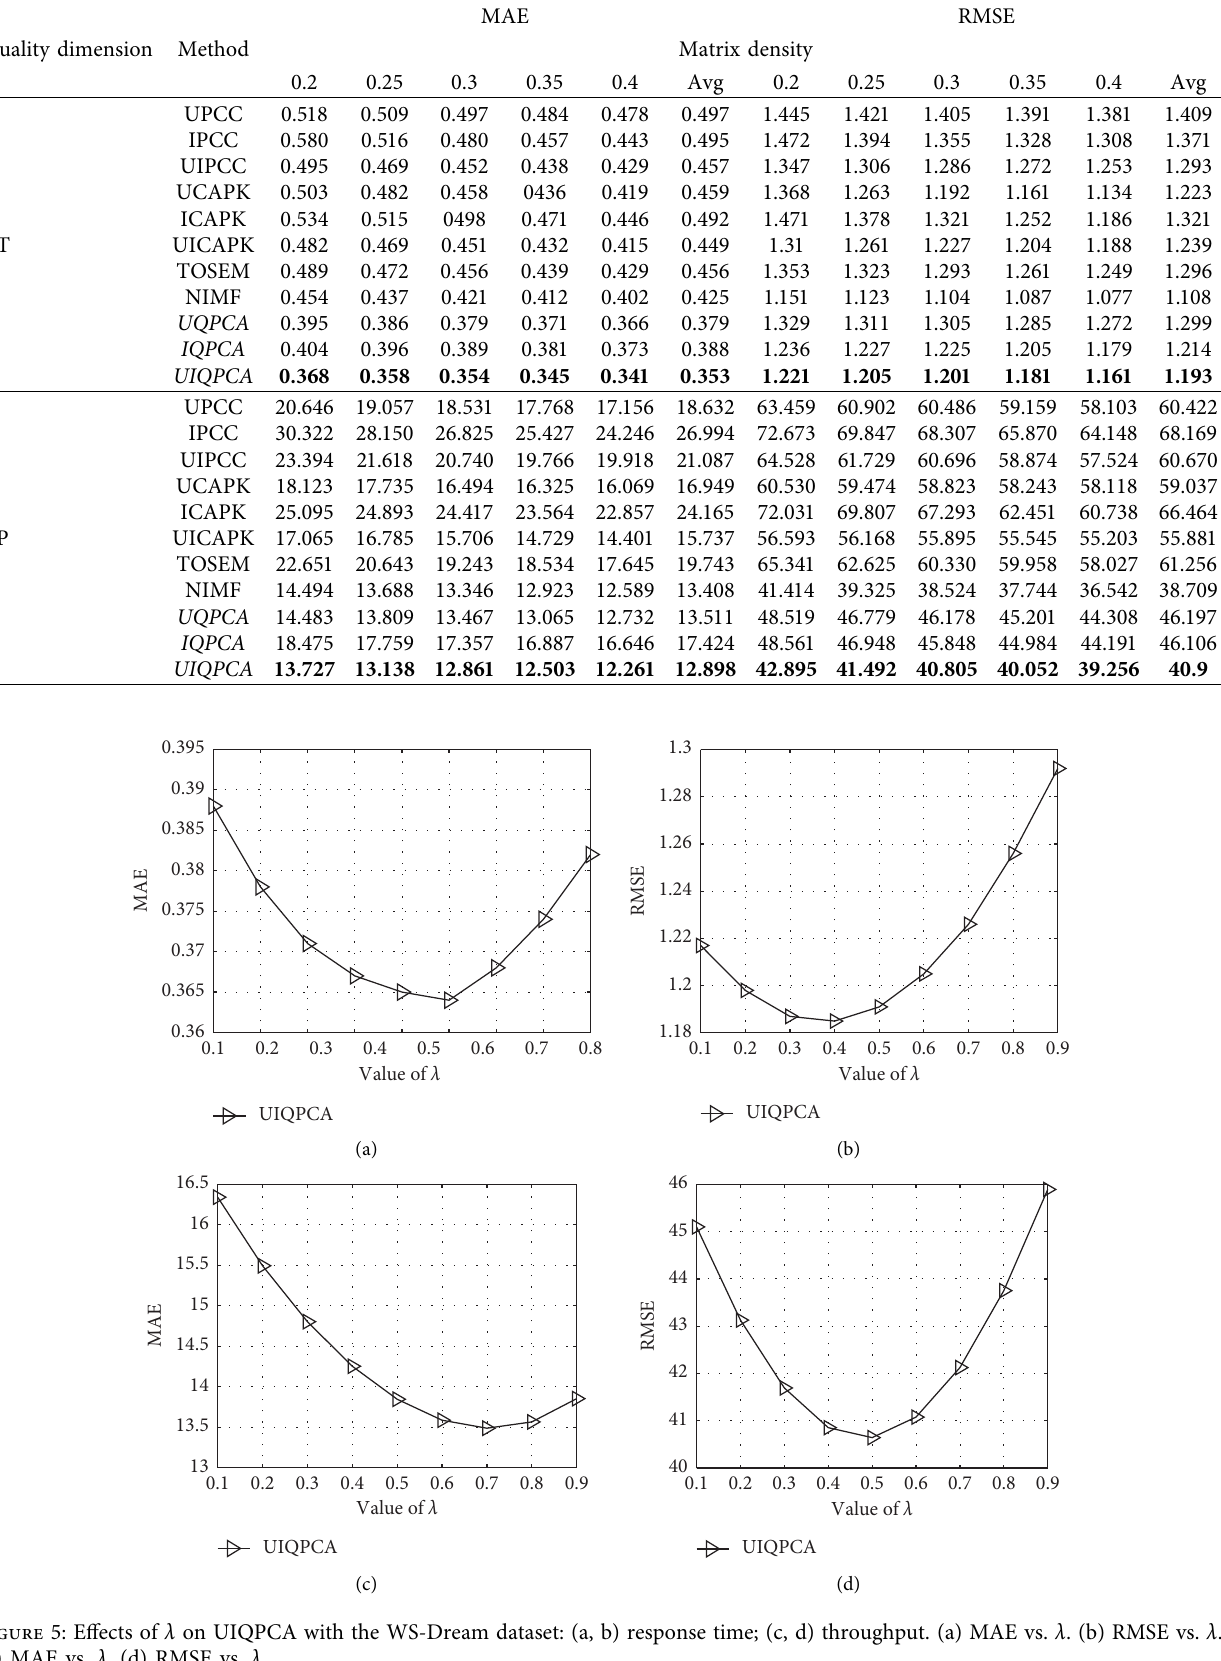
Table 1: Comparison of MAE and RMSE on the WS-Dream dataset ( λ � 0.6, k � 2). Quality dimension Method